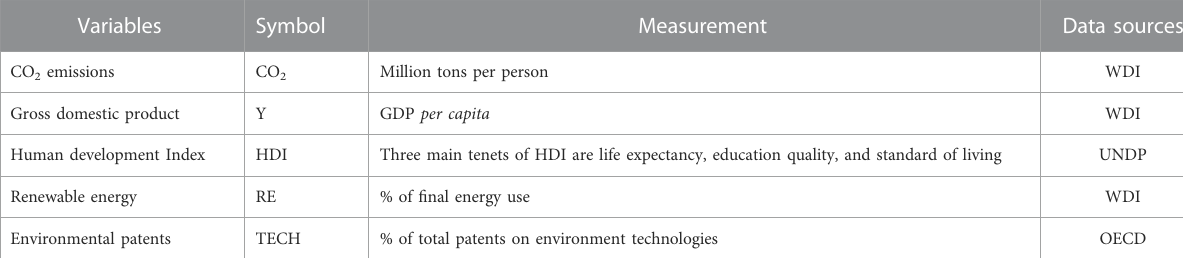
TABLE 1 Data variables and sources (1995 –